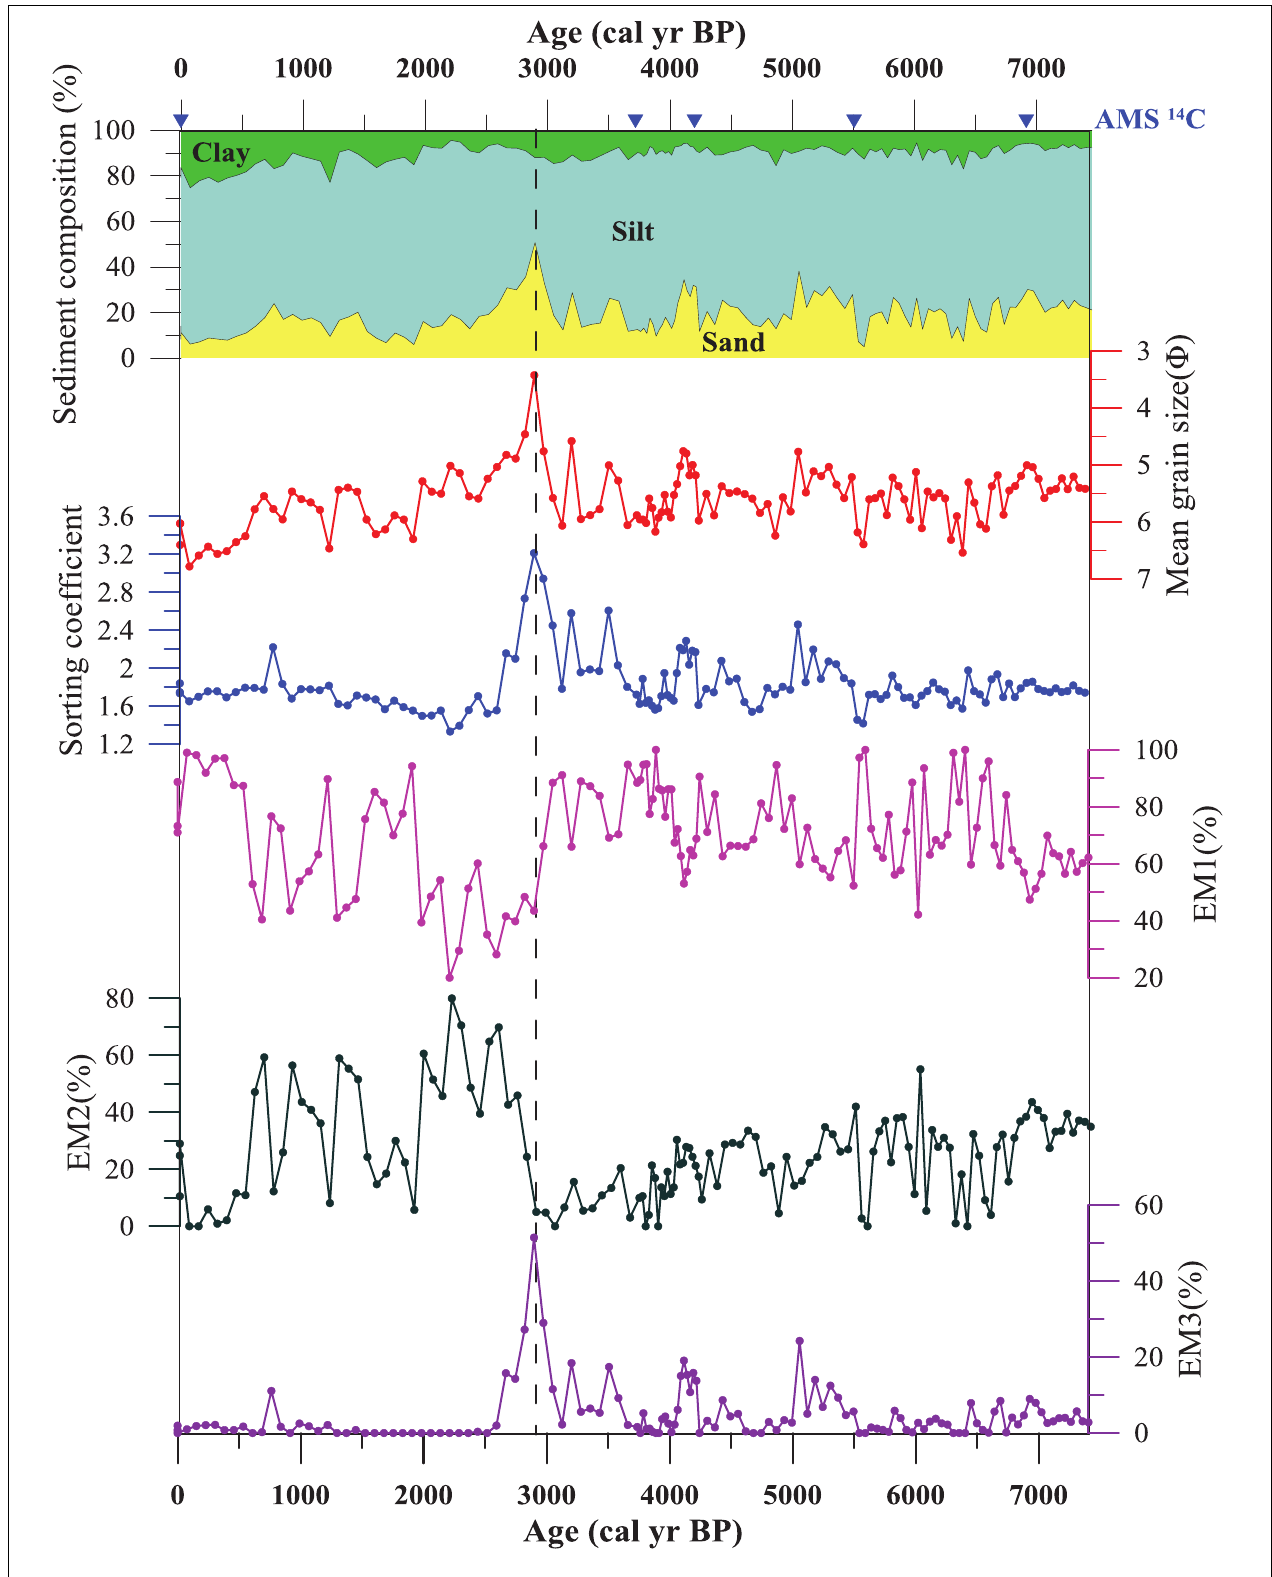
FIGURE 3 | Variations in grain size of Core